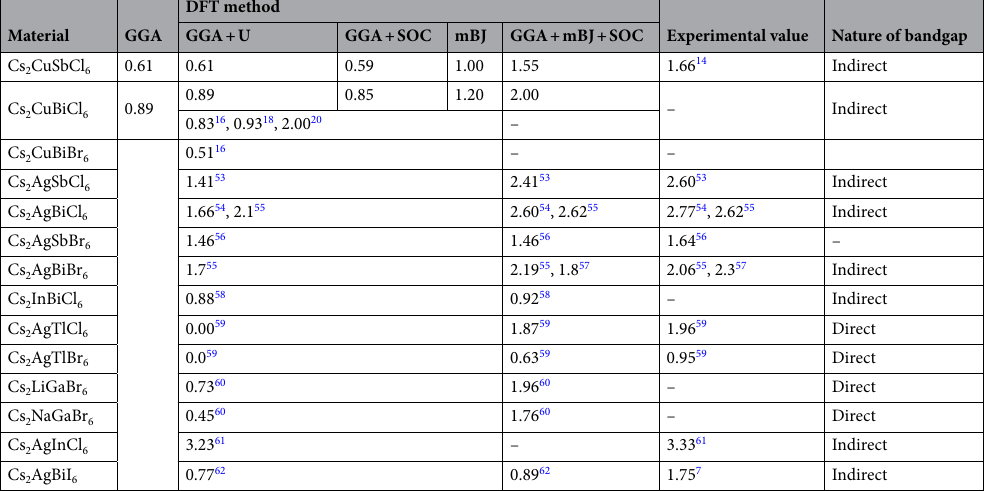
Table 3. Calculated band gap and nature of band gap of Cs 2 CuMCl 6 (M = Sb, Bi) in present study in comparison with experimental and other theoretical results available in literature.